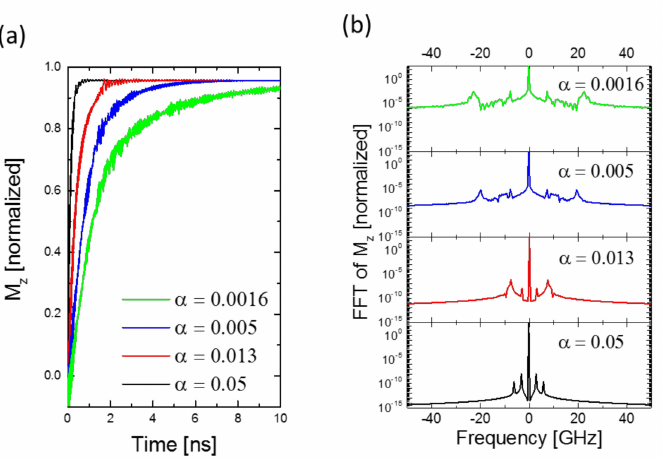
Figure 2. Damping coefficient dependence of z-axis transmission, where 3 GHz RF signal is used for the excitations. The effect of increasing Gilbert damping coefficient on transient M z in ( a ) time and ( b ) frequency (for 8–10 ns time window) domains (the rest of the parameters were fixed). The nanogratings with lower damping coefficients transmit higher-frequency oscillations with higher transmission